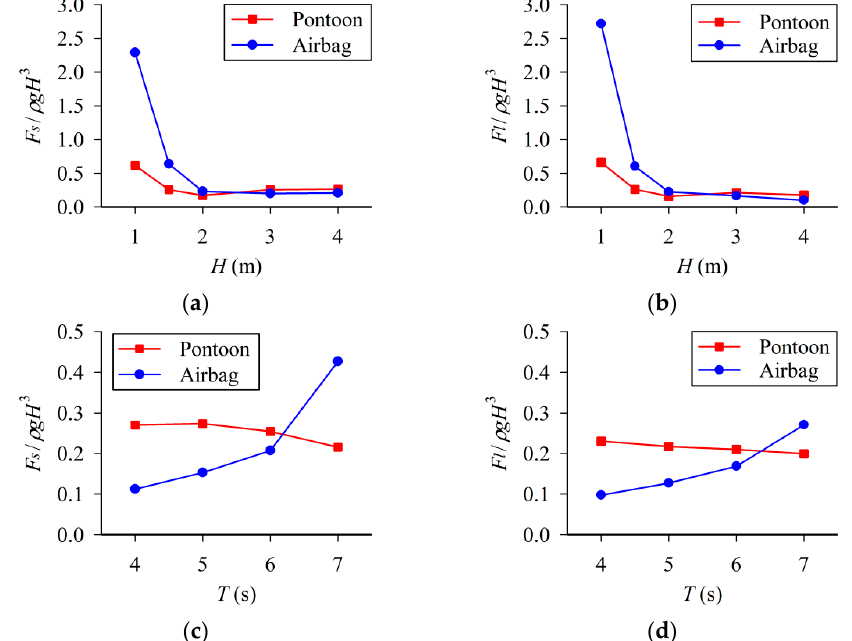
Figure 18. Comparison of the mooring force of the double-row floating breakwater under different wave parameters: ( a ) Seaward side F s , H = 1–4 m and T = 6 s; ( b ) Leeward side F l , H = 1–4 m and T = 6 s; ( c ) Seaward side F s , H = 3 m and T = 4–7 s; ( d ) Leeward side F l , H = 3 m and T = 4–7 s.